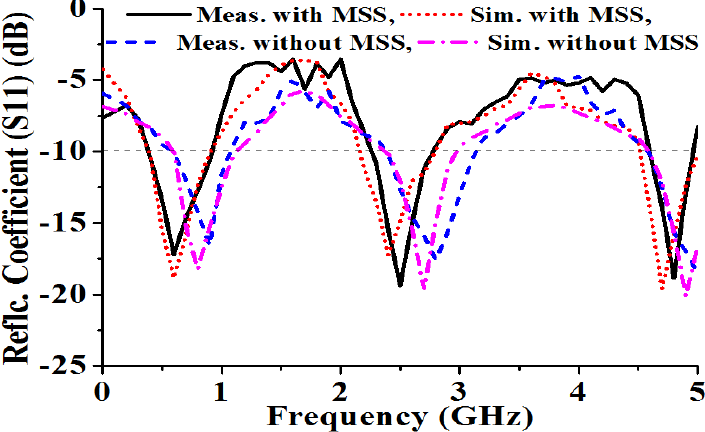
Figure 5. Reflection coefficients of the proposed array with and without the